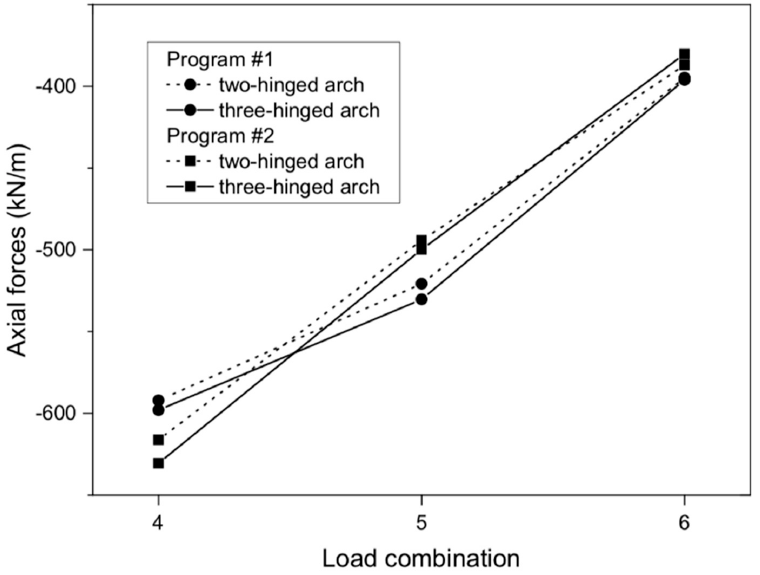
Figure 8. Axial forces of arch viaduct vs. load combinations.